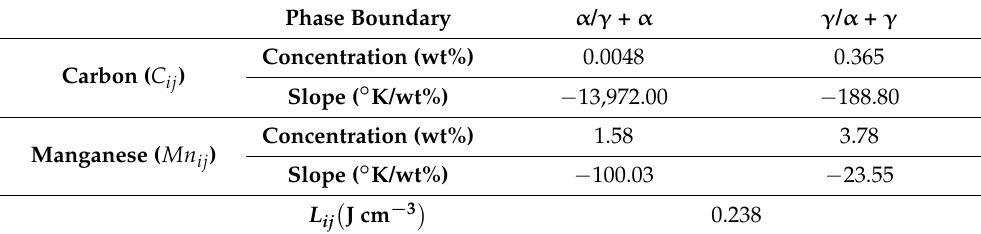
Table 2. Linearized data for the phase diagram at T 1 = 1043.